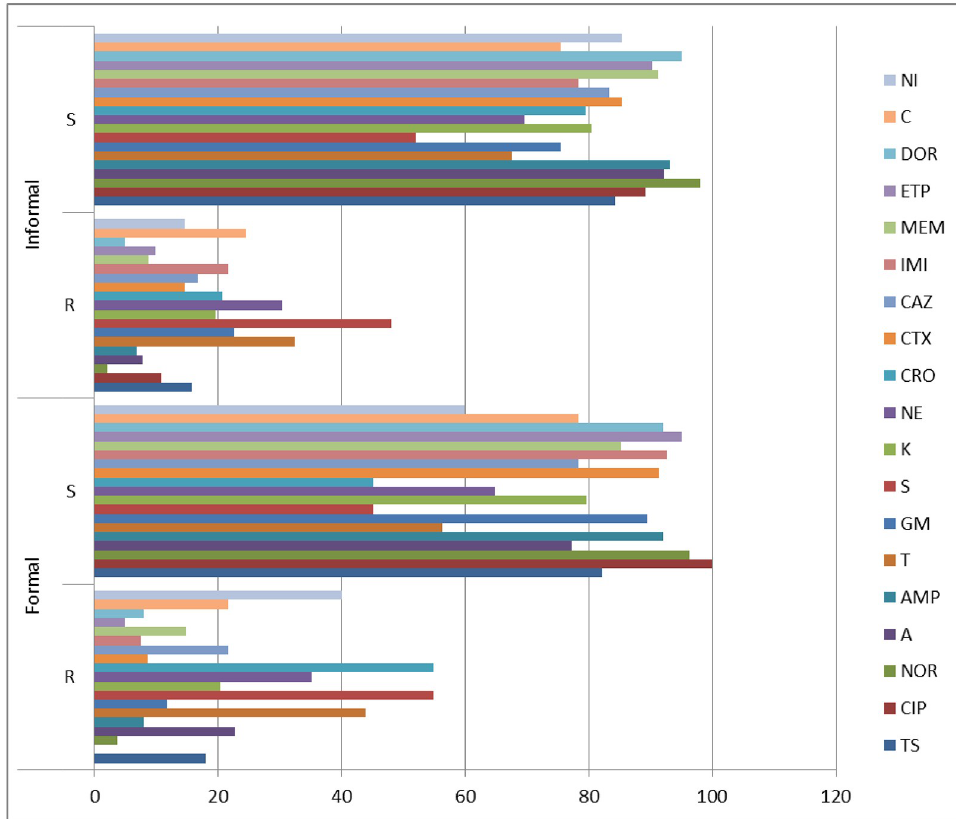
Fig 2. Antibiotic susceptibility pattern of E. coli isolates. R: resistant, S: susceptible, Cotrimoxazole: TS, Ciprofloxacin: CIP, Norfloxacin: NOR, Amoxicillin: A, Ampicillin: AMP, Tetracycline: T, Gentamicin: GM, Streptomycin: S, Kanamycin: K, Neomycin: NE, Ceftriaxone: CRO, Cefotaxime: CTX, Ceftazidime: CAZ, Imipenem: IMI, Meropenem: MEM, Ertapenem: ETP, Doripenem: DOR, Chloramphenicol: C, Nitrofurantoin: